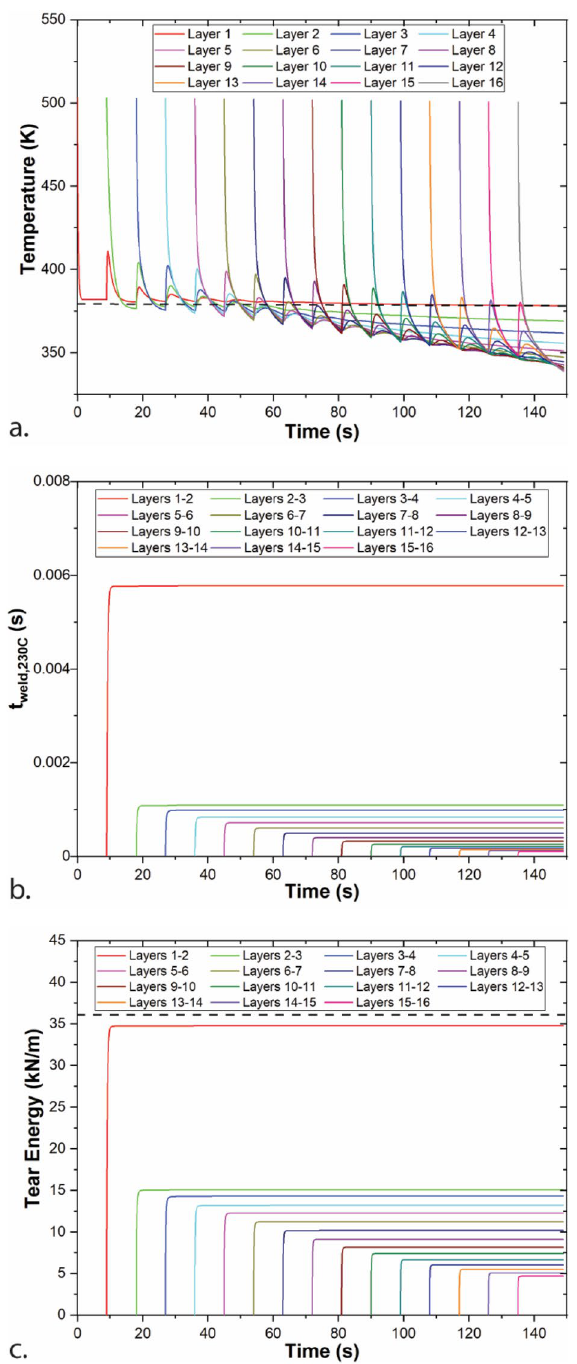
Figure 1. Baseline model results for printing of a single road width wall of ABS for T ext = 230 °C, v print = 30 mm/s, h = 0.3 mm. Geometry and print conditions are based on Ref. 17 . ( a ) Layer temperature; ( b ) weld time at a reference temperature of 230 °C; ( c ) tear energy at interfaces between